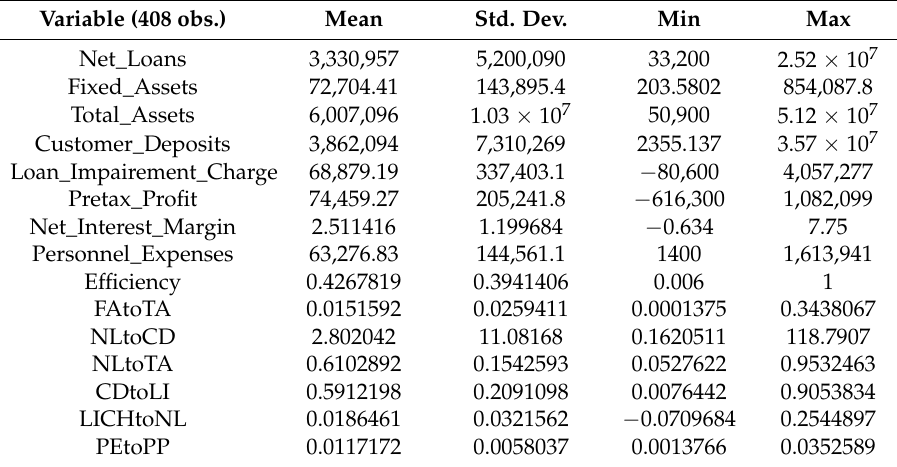
Table 1. Variables and descriptive statistics.